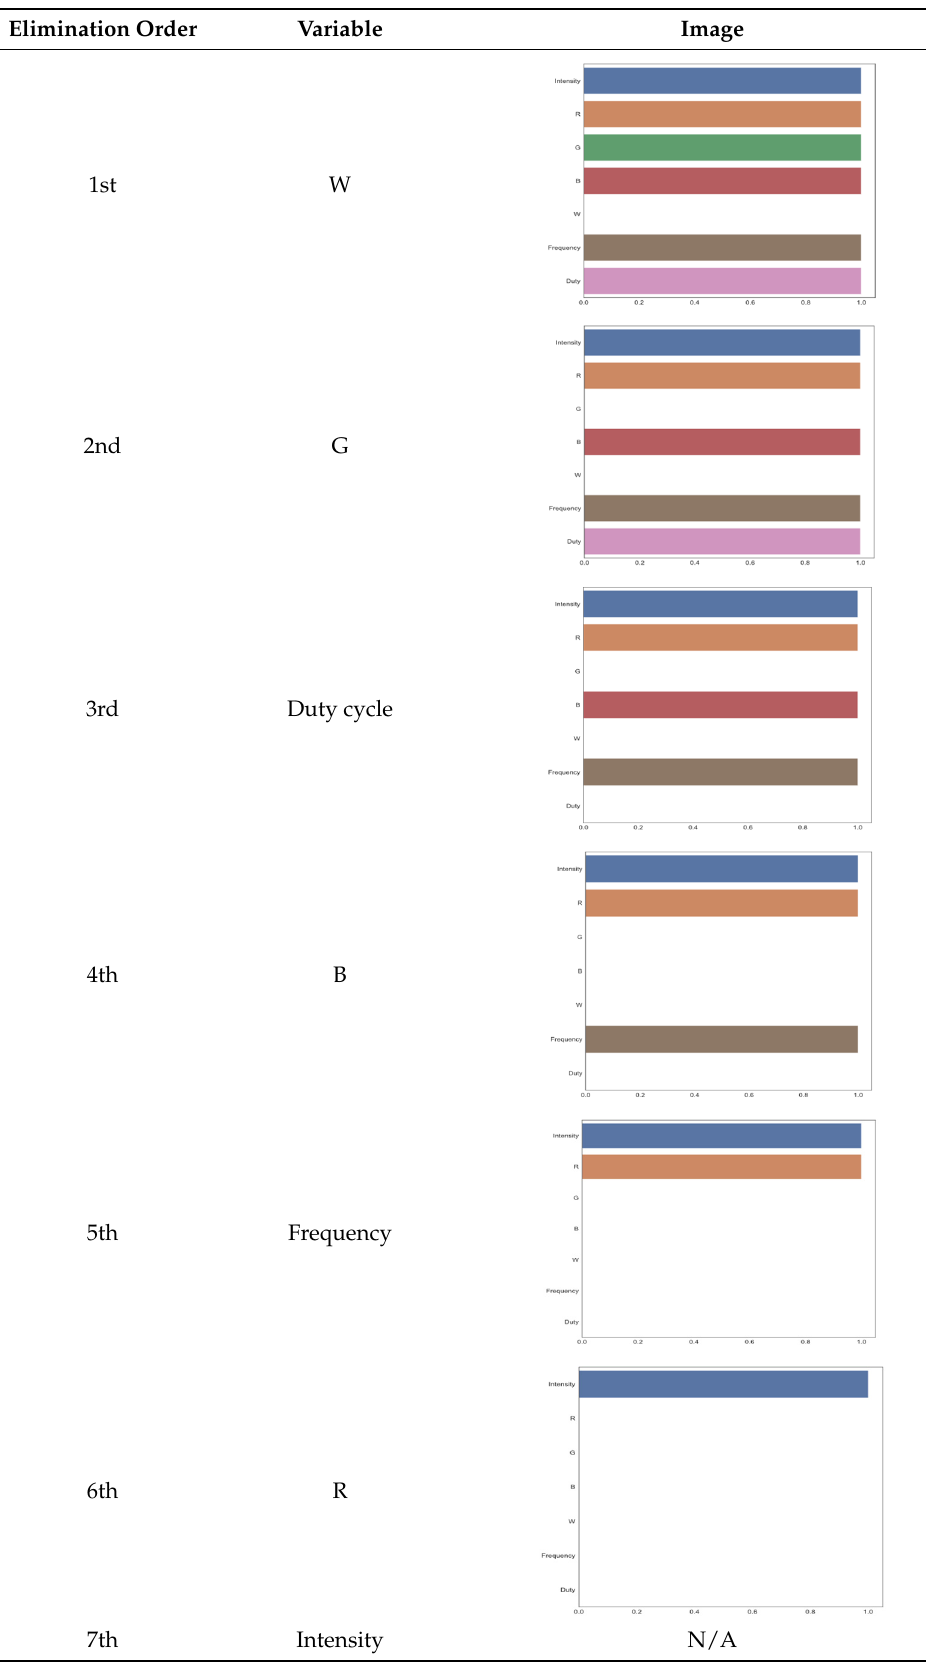
Table 11. Sequential feature selection by decision tree for depth = 5.